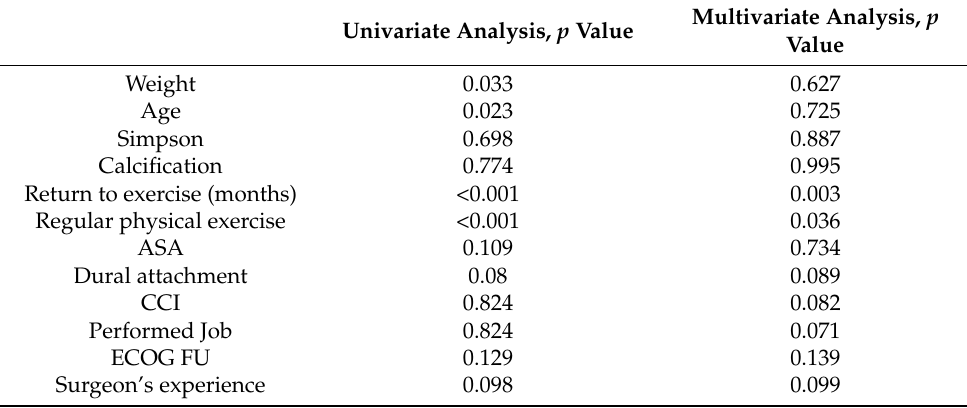
Table 6. Univariate/multivariate analysis affecting early return to work after